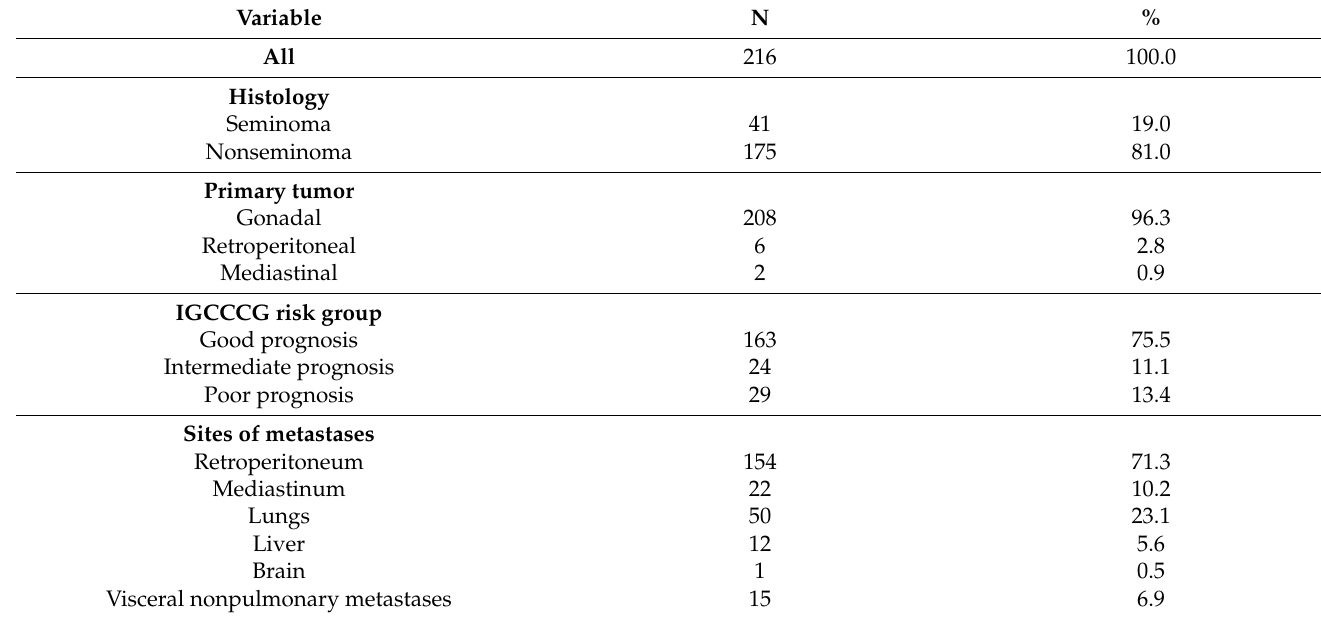
Table 1. Patient